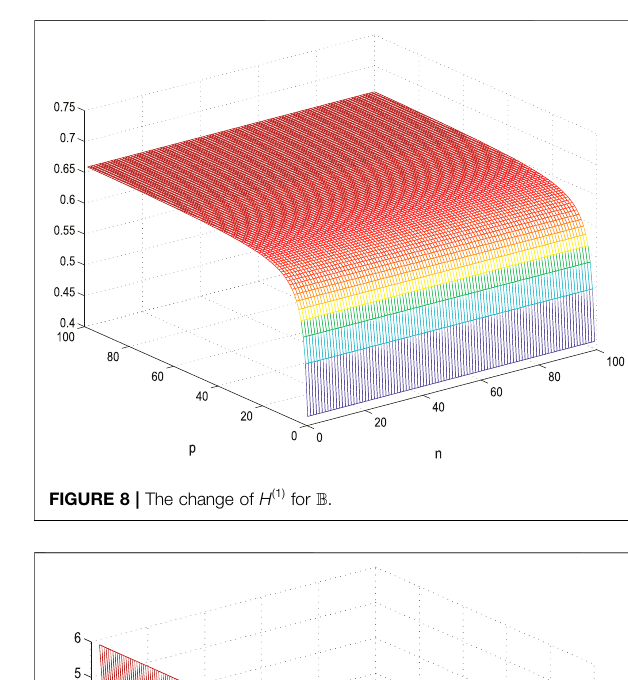
FIGURE 7 | The change of H (1) for A .